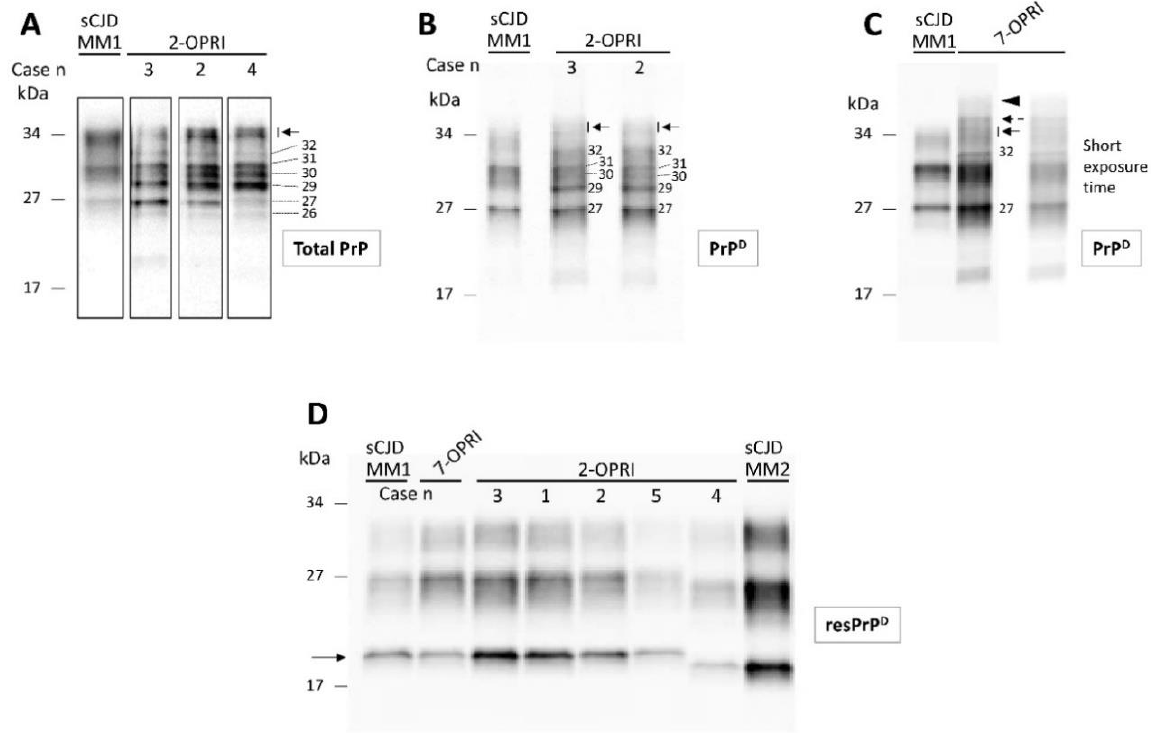
Figure 2. Western blot profiles of total PrP, detergent-insoluble PrP D and resPrP D : Samples harvested from the cerebral cortex were probed with the anti-PrP antibody 3F4. ( A ): Total PrP showing a complex PrP profile in 2-OPRI cases but not in sCJDMM1. The approximate molecular size of each band is indicated by the numbers on the right; arrow: PrP doublet of ~34–35 kDa. ( B ): Western blot (WB) profile of detergent-insoluble PrP D harvested from 2-OPRI resembles that of total PrP except for the absence and weak presence of the ~26 and ~30 kDa fragments, respectively. ( C ): Insoluble PrP D WB profile of a 7-OPRI features a sharp band of ~32 kDa, a PrP D triplet in the ~34–36 kDa region, and a PrP D smear of ~42–44 kDa, whereas the PrP D region of ~31 to 27 kDa resembles that of sCJDMM1. ( D ): The un-glycosylated isoform of resPrP D (arrow) in 2-OPRI-MM1 (cases 1–3), 2-OPRI-MM1-2 (case 5), and 7-OPRI-MM1 migrates to ~20 kDa, matching the gel mobility of resPrP D type 1 (sCJDMM1). The un-glycosylated resPrP D of 2-OPRI-MV1-2 (case 4) migrates to ~19 kDa, thus matching the gel mobility of sCJDMM2 resPrP D type 2.